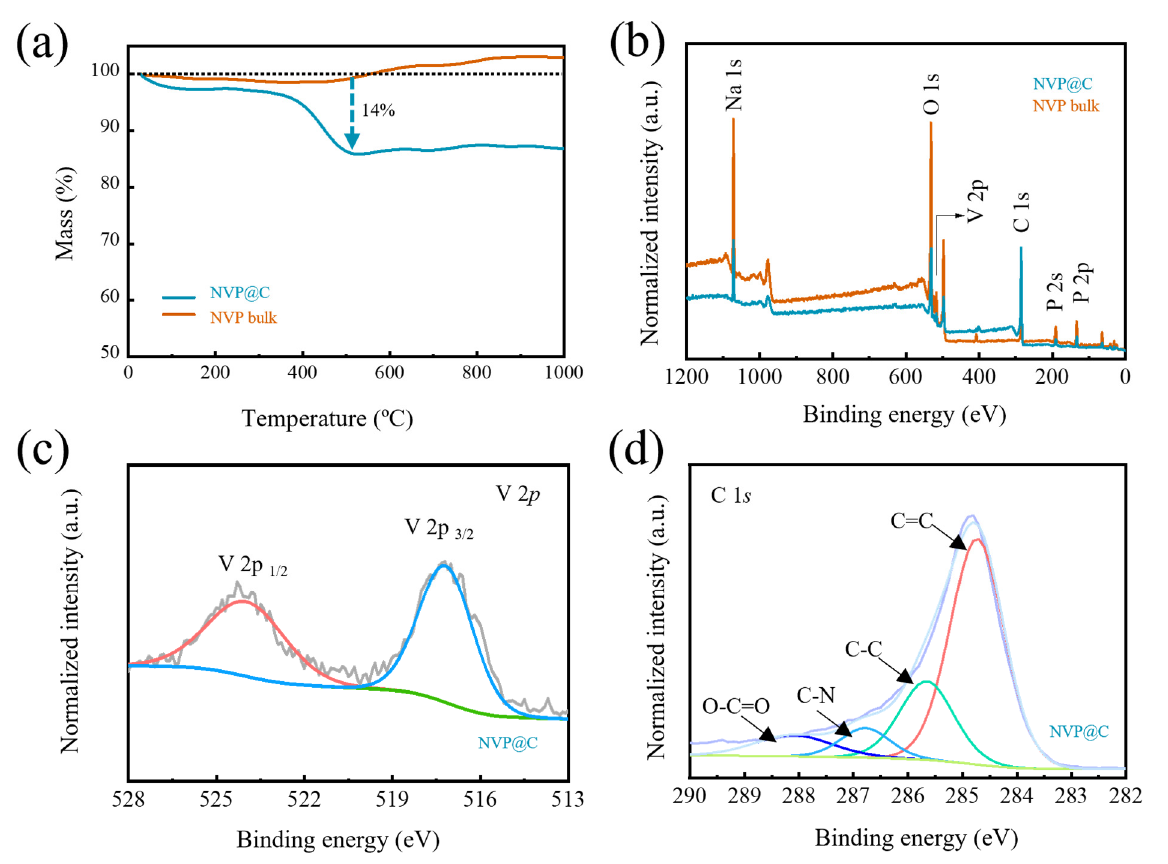
Figure 2. ( a ) TG curves of NVP@C and NVP bulk; ( b ) XPS full spectra, ( c ) V 2p spectra and ( d ) C 1s spectra of NVP@C and NVP bulk.